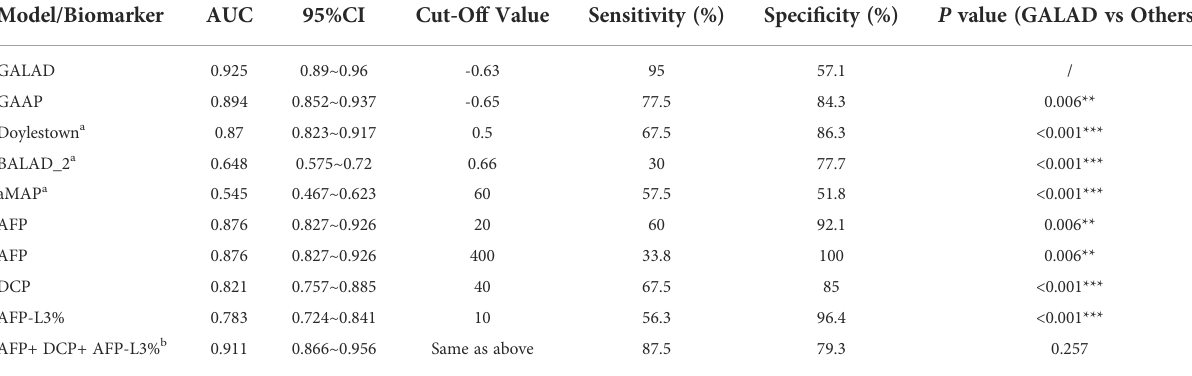
TABLE 6 ROC curve analysis of HCC prediction models and serum biomarkers for discriminating HCC (n=80) and CLD groups (n=140).